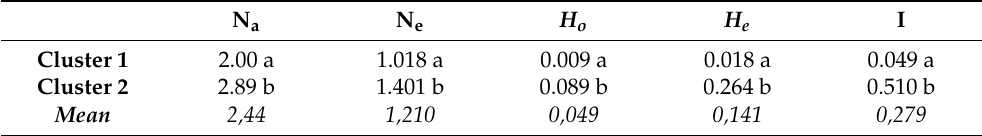
Table 6. Genetic diversity parameters calculated for accessions of Clusters 1 and 2 defined by STRUCTURE analysis. Average values of allele number (N a ), effective number of alleles (N e ), observed heterozygosity ( H o ), expected heterozygosity ( H e ), and Shannon information index (I). For each parameter (data column), different letters indicate significant differences ( p <